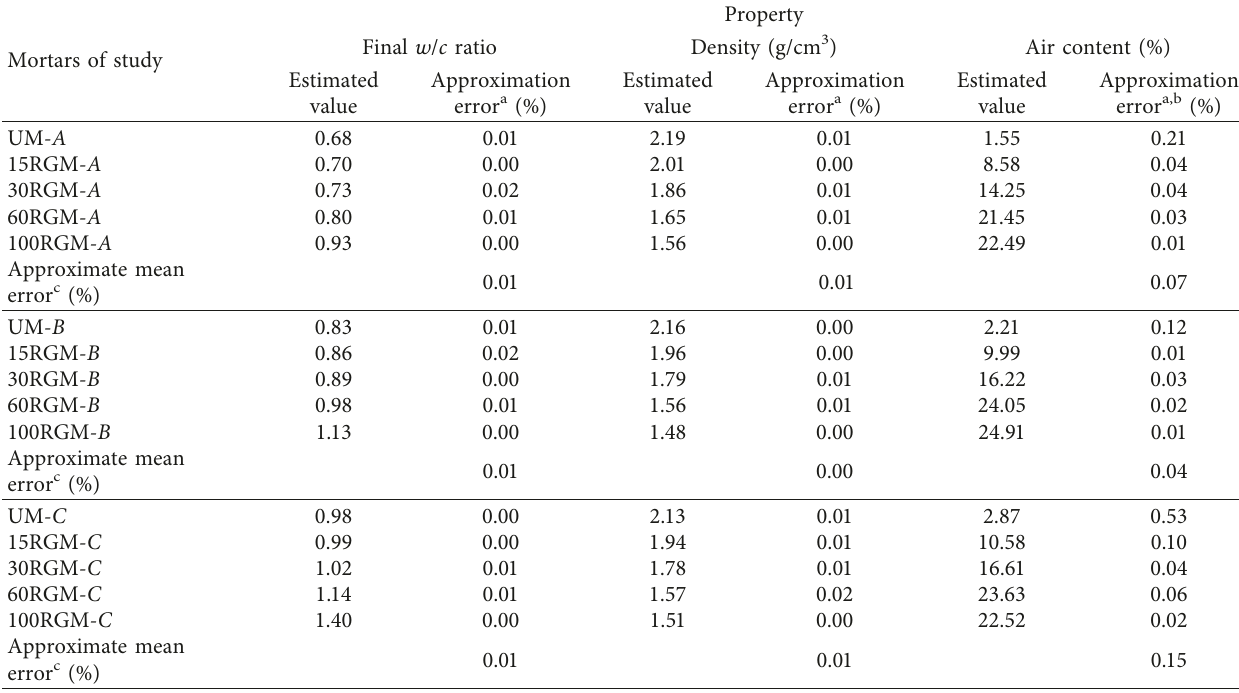
Table 4: Theoretical values of the RGM properties and approximation errors.